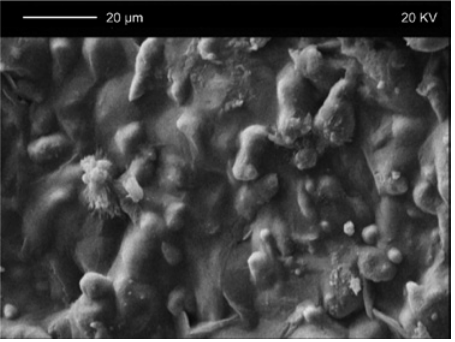
Figure 4 The scanning electron micrograph of feedstock denoted as A in Table